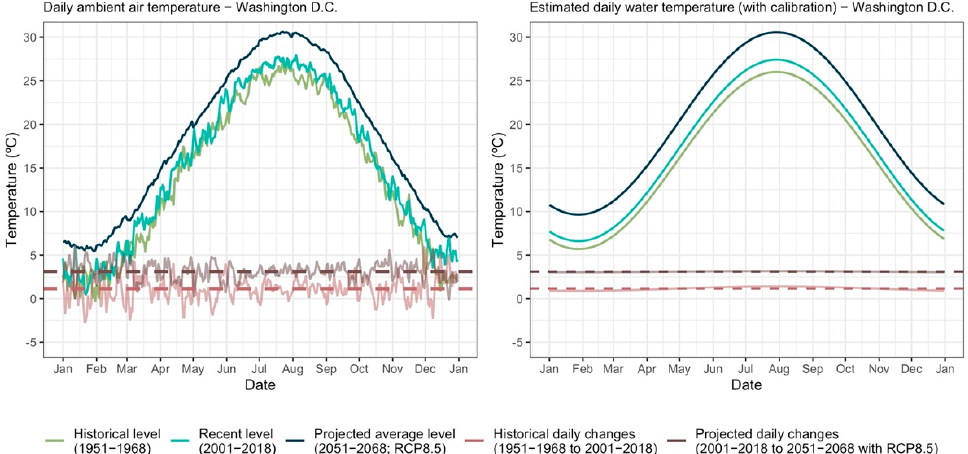
Figure 3. An assessment of daily air temperature records and projection and daily water temperature estimates between a historical period (1951–1968), a recent historical period (2001–2018), and a projected future period (2051–2068) for Washington D.C. The results of the daily air temperature in the two historical periods are the averaged daily values for the two periods, while the presented air temperature projection is an average projection in daily resolution from the G-ARIMA model (and consequently exhibits less daily variations compared to the two historical levels). The three periods were assessed because of the avaialable measurements for the period 2001–2018. Daily water temperature estimates were calculated based on the air temperature of these three periods. The results of the daily changes and their annual averages (presented as the dashed lines) are based on the differences of the daily water temperature estimates between the three periods.